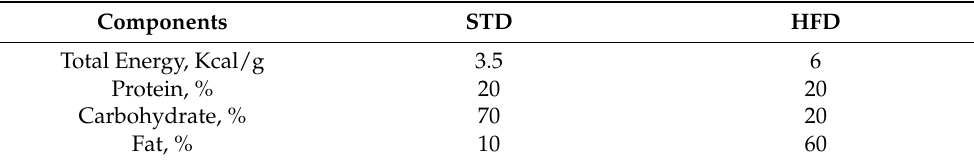
Table 1. Energy density and macronutrients composition of standard diet (STD) and high fat diet